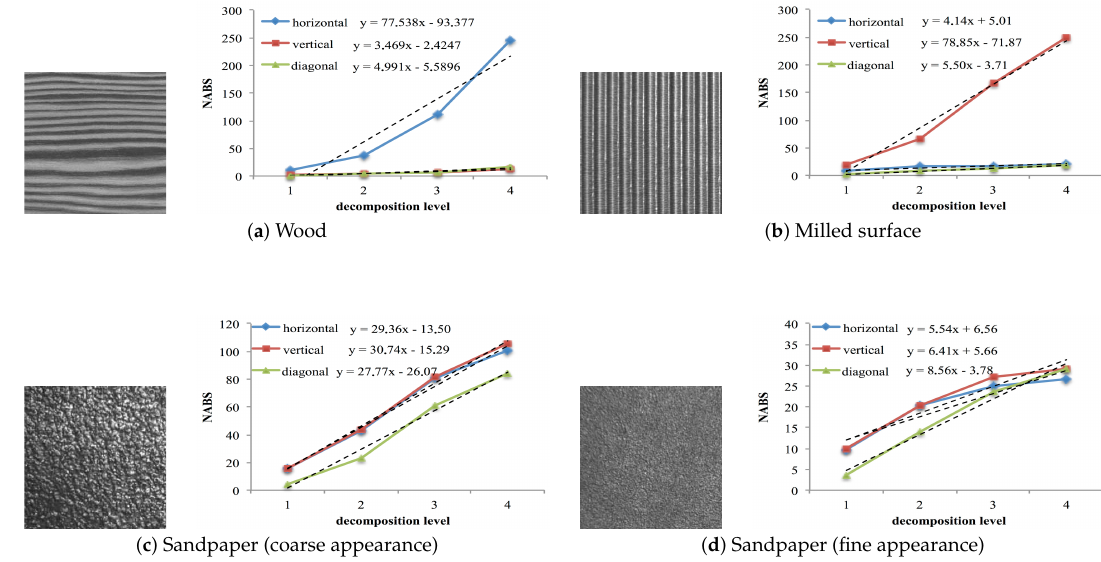
Figure 7. Graphic representation of the normalized absolute function values (NABS) ( NABS j NABS j ) and their trend line equations calculated at four decomposition levels of images ( a – d ). Notice d that textures ( a , b ) are selected to be highly directional since they show a trend line slope significantly greater than the others corresponding to certain